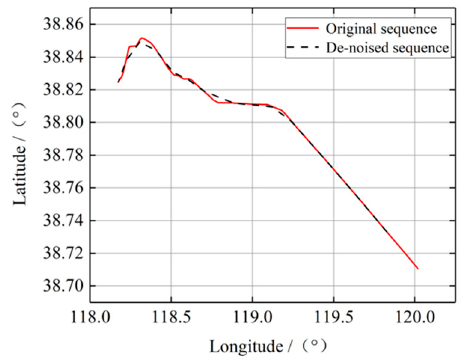
Figure 5. Comparison of original and de-noised sequences.